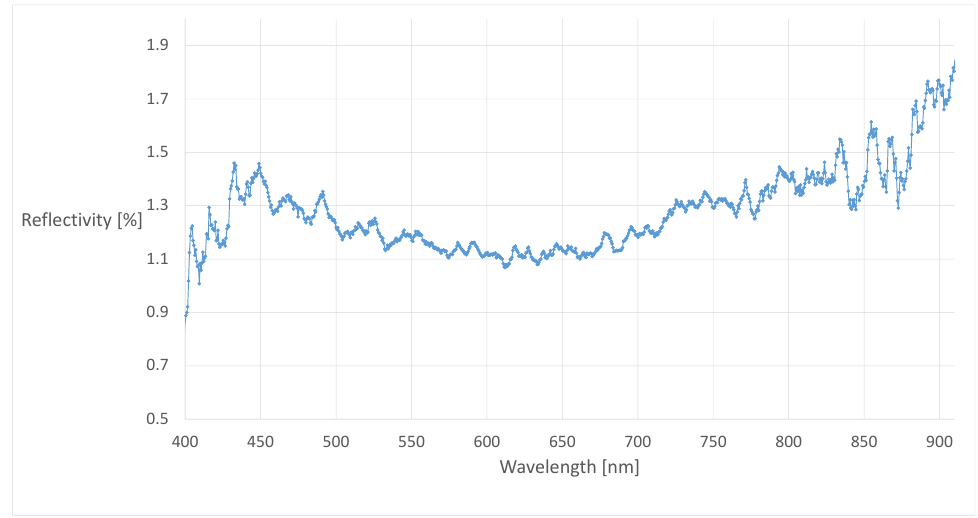
Figure 3. Surface reflectivity of the new cotton dress in the wavelength range from 400 nm to 910 nm. It can be seen in Figure 3 that the new cotton has a reflectivity between 1.29% and 1.85% in the wavelength range from 850 nm to 910 nm and falls below the normative range of 2–6%. Since a deterioration of the reflectivity is expected during permanent outdoor use, the low reflectivity is considered suitable. For systems, e.g., cameras, which do not only work in the NIR wavelength range, the wavelength range between about 400 nm and 780 nm in the visible light range is also presented in Figure 3. For this wavelength range, the new cotton has a reflectivity between 0.89% and 1.46%. The aging of the materials during outdoor use is checked and taken into account by spectral